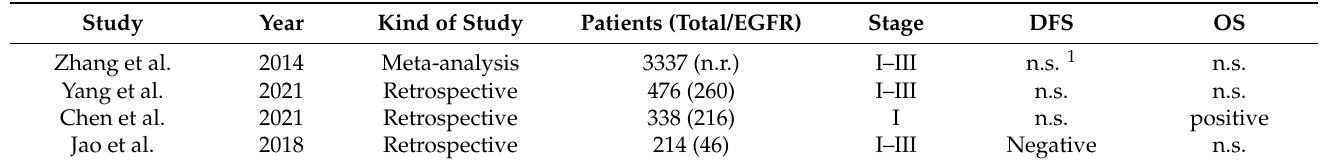
Table 1. Disease-free survival (DFS) and overall survival (OS) in early-stage NSCLC with EGFR